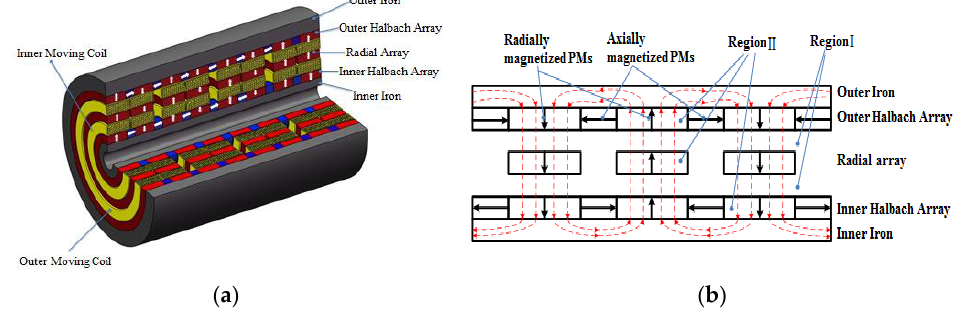
Figure 1. Tubular linear machine with hybrid magnet arrays: ( a ) Schematic machine structure; ( b ) Magnetization and flux.